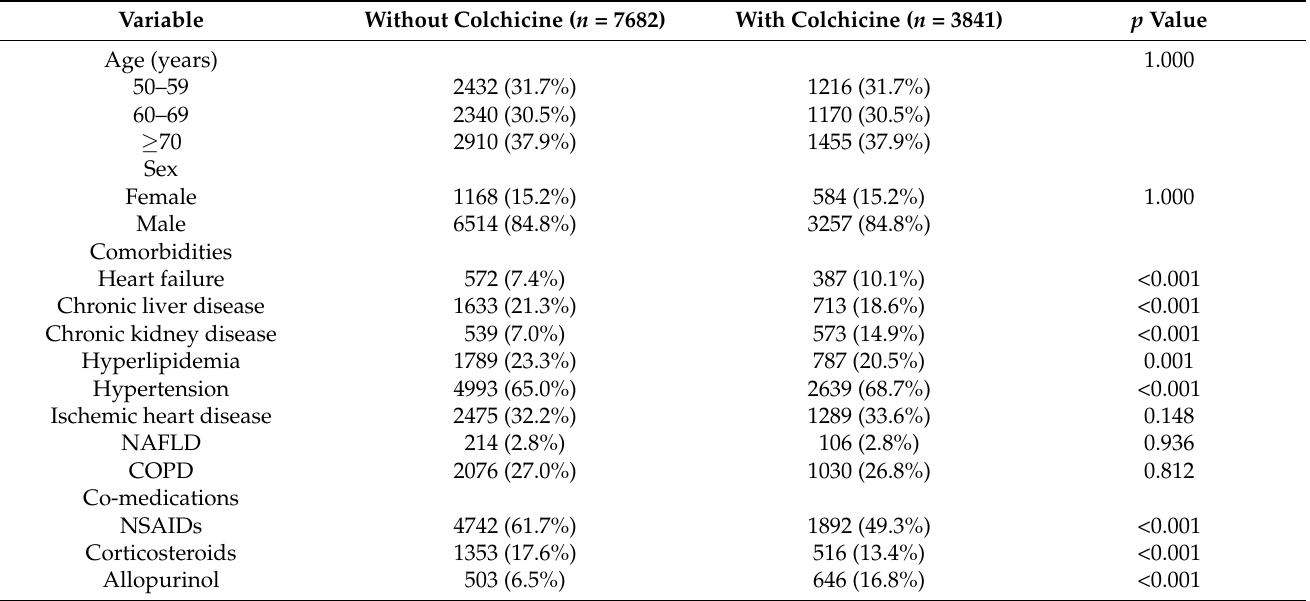
Table 1. Baseline characteristics of study